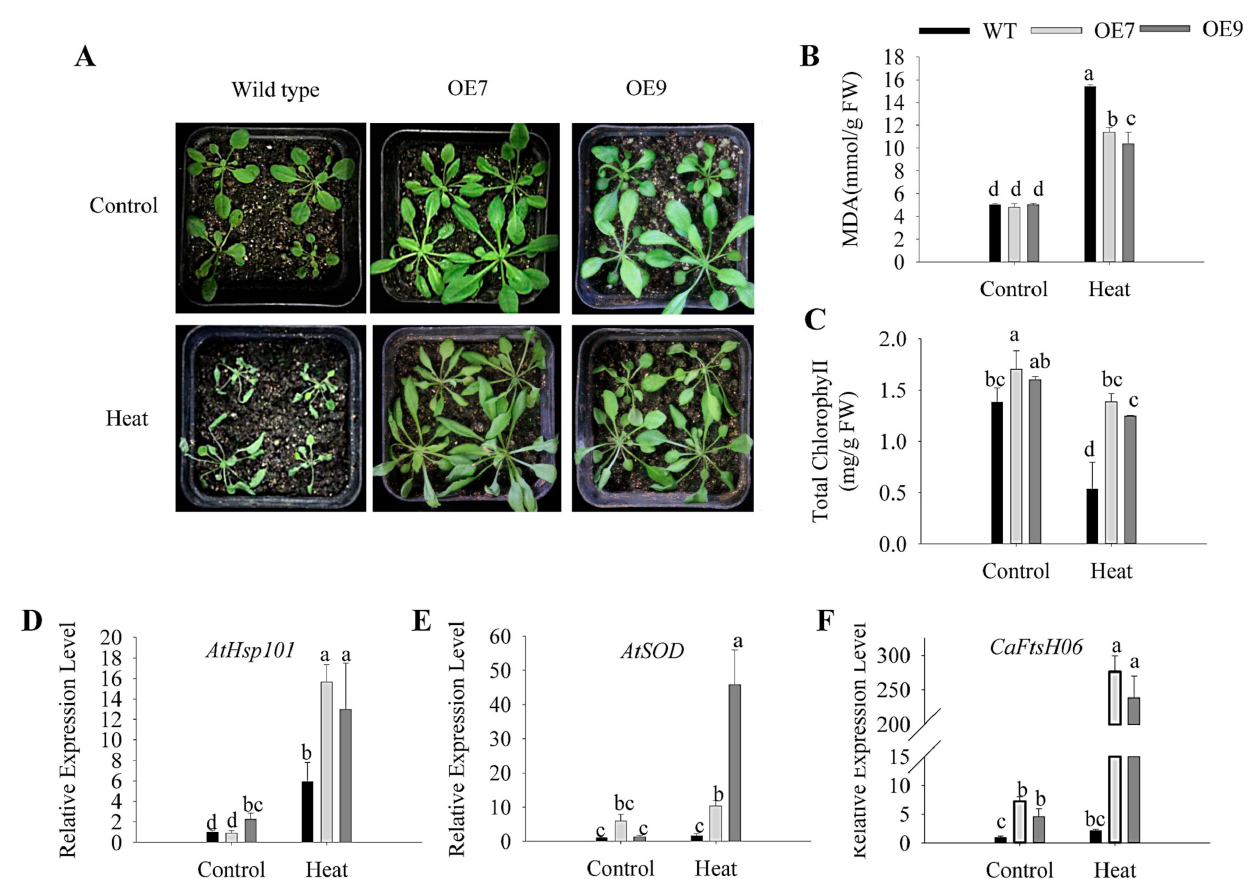
Figure 10. Heat stress tolerance analysis of WT and CaFtsH06 -expressing Arabidopsis lines following 40 ◦ C treatment for 24 h. ( A ) The phenotype of WT and CaFtsH06 -expressing Arabidopsis lines. ( B , C ) MDA and total chlorophyll contents of activity of WT and transgenic Arabidopsis. ( D – F ) Relative expression level of WT and CaFtsH06 -expressing Arabidopsis lines. Different letters denote statistical significance ( p <